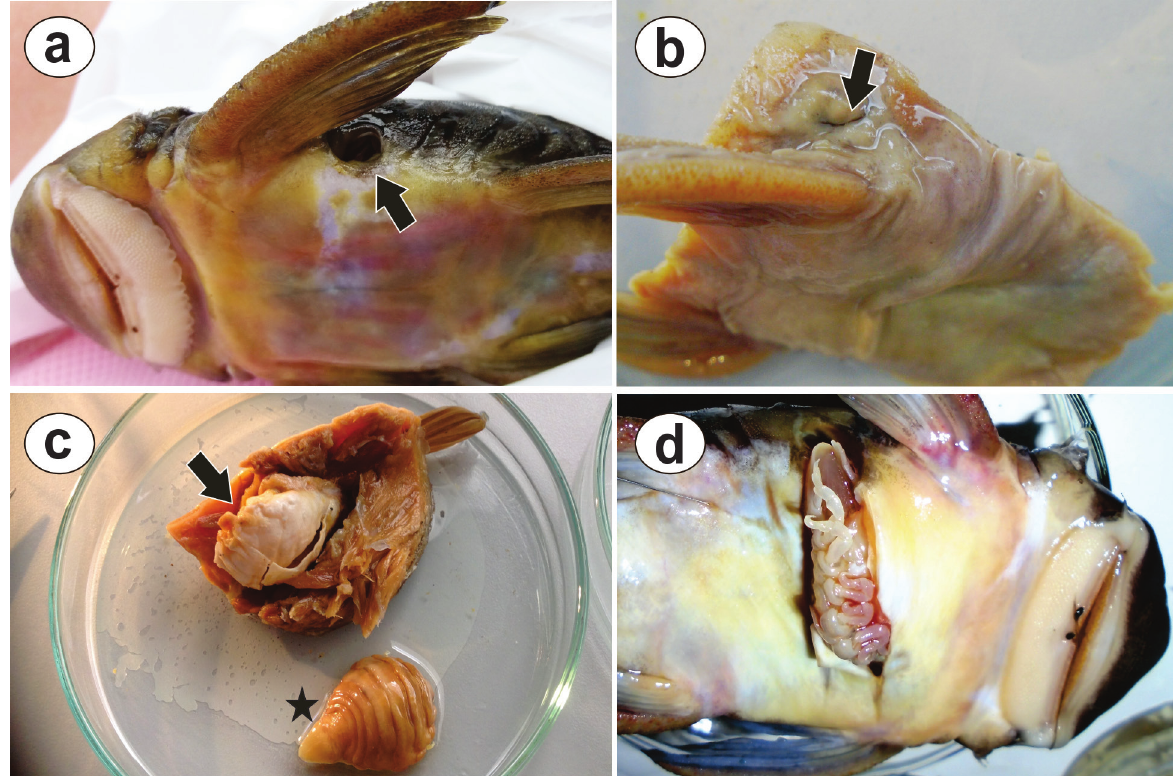
Figure 2 - a. Specimen of Chaetostoma breve shows a pore (arrow) on the lateral flank. b. Obliteration of the pore, giving rise to a scar (arrow). c. The skin (arrow) that forms a sort of pocket or pouch in the abdominal cavity of the fish. Female of Riggia puyensis , dorsal view (star). d. Position of the crustacean in the abdominal cavity, with the pleotelson showing its caudal tip through the